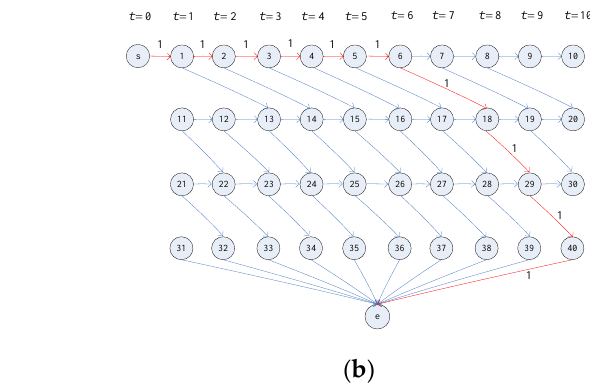
Figure A2. ( a ) Rerouted flows due to resource failure in RSTN 1 ( V 1 , A 1 ) ; ( b ) Rerouted flows due to resource failure in RSTN 2 ( V 2 , A 2 ) .